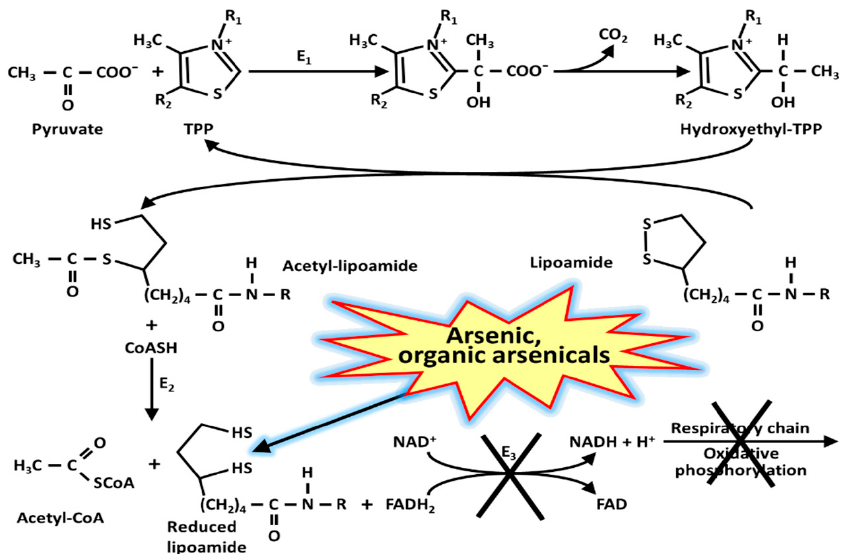
Figure 2. Effect of arsenic on pyruvate dehydrogenase complex. Arsenic and organic arsenicals form an adduct with the two –SH groups of dihydrolipoamide that alter the function of dihydrolipoyl dehydrogenase affecting the respiratory chain and the oxidative phosphorylation (E 1 : pyruvate decarboxylase; E 2 : dihydrolipoyl transacetylase; E 3 : dihydrolipoyl dehydrogenase. TPP: thiamine pyro phosphate; FAD: flavin adenine dinucleotide; FADH 2 : reduced FAD; NAD + : nicotinamide adenine dinucleotide; NADH: reduced NAD + ; CoASH: Coenzyme A). This figure is an elaboration based on information retrieved from ref.